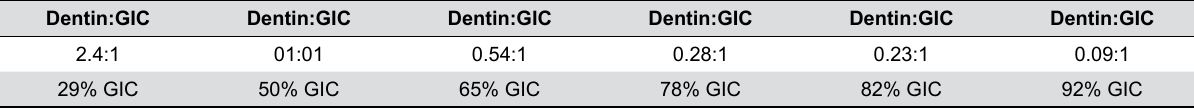
Table 1- Ratio of glass-ionomer cement (GIC) samples weight